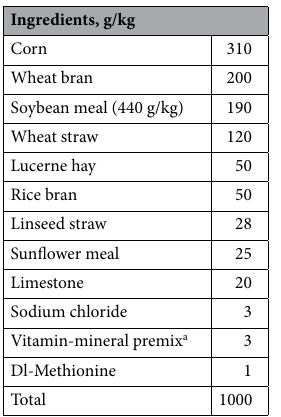
Table 1. Ingredient composition (as-fed basis) of the diet fed to rabbits throughout the experiment. a Per